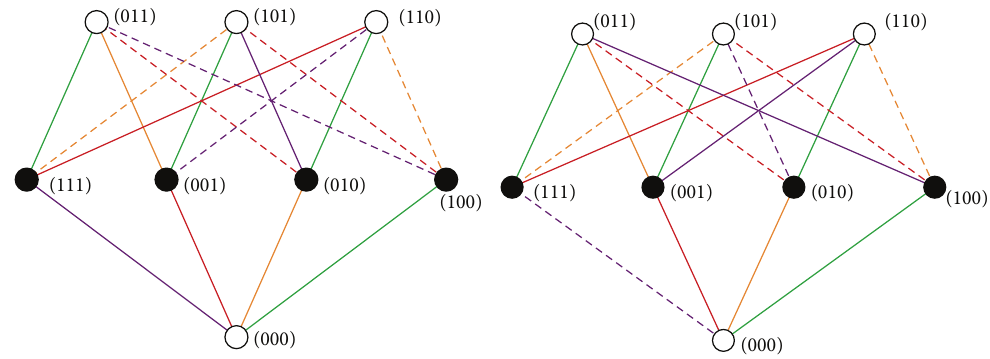
Figure 4: Two (4, 1) Adinkras with switching state in standard